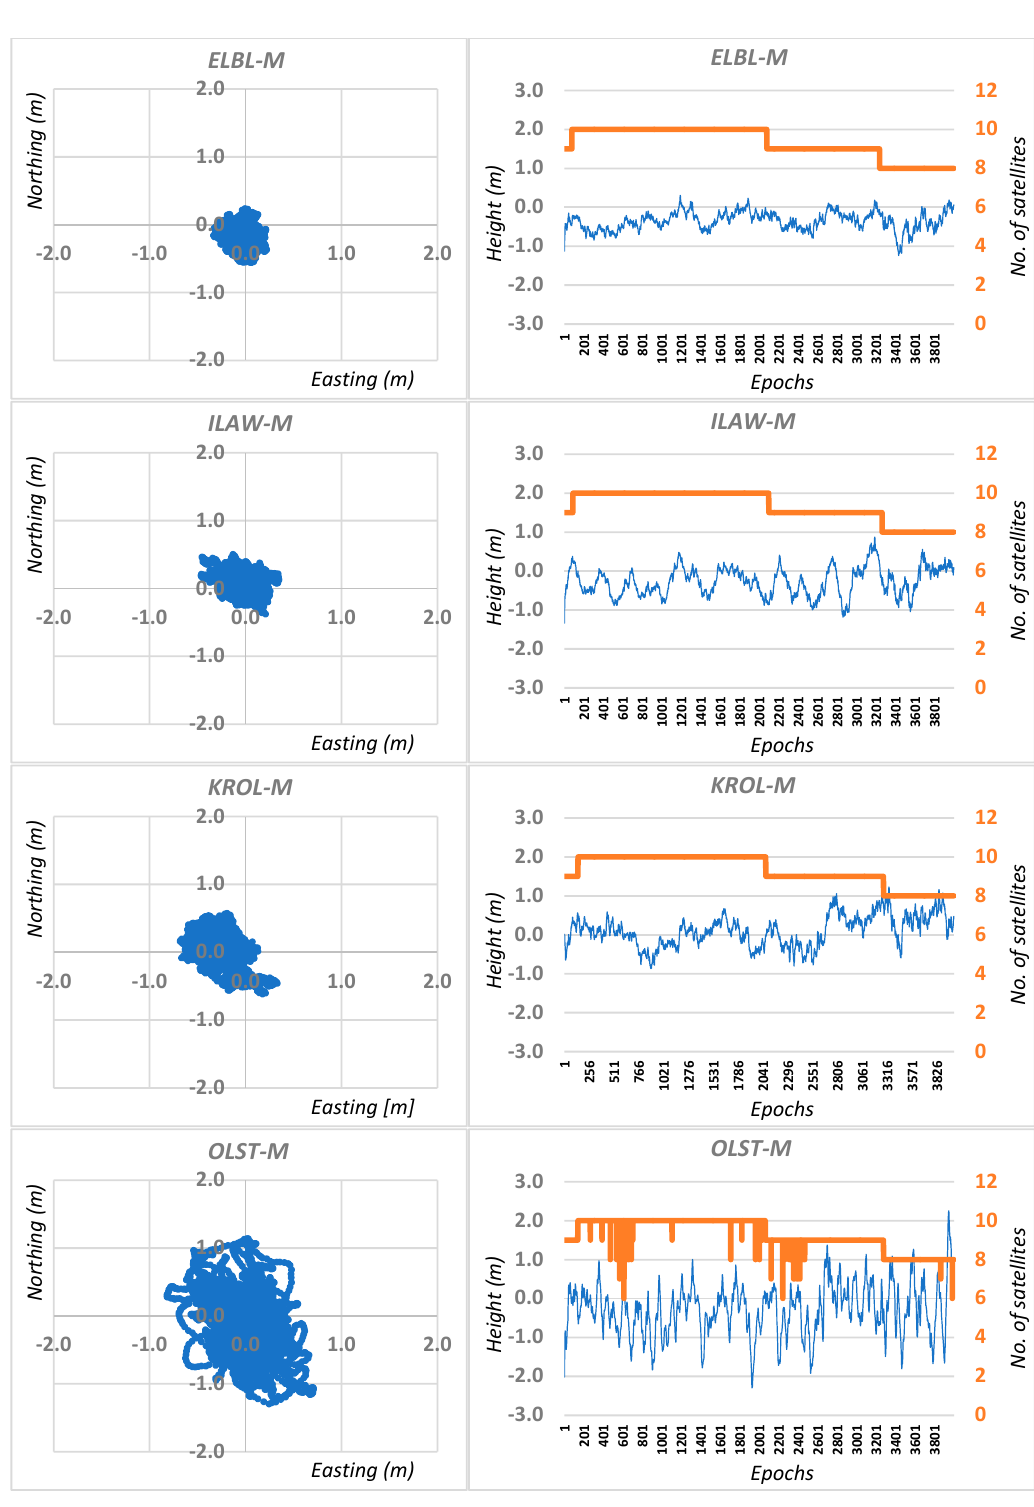
Figure 3. Real errors of single epoch DGPS positioning based on least squares solutions and Kalman filtering for session I.